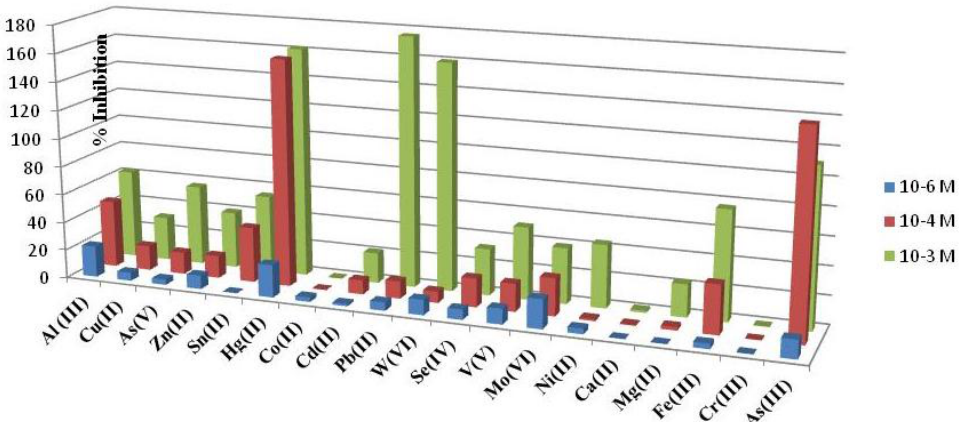
Figure 4. Inhibition percentage of inhibition current of ACh AuNPs/SPCE in presence of: Cu(II); As(V); As(III); Zn(II); Sn(II); Hg(II); Co(II); Cd(II); Pb(II); W(VI); Se(IV); V(V); Mo(VI); Ni(II);Ca(II); Mg(II); Fe(III); Cr(III); As(III) at three levels of concentration; [ATI] 0.12 µM; Eap, + 0.8 V vs. Ag/AgCl screen printed electrode; Britton-Robinson pH 7.8.